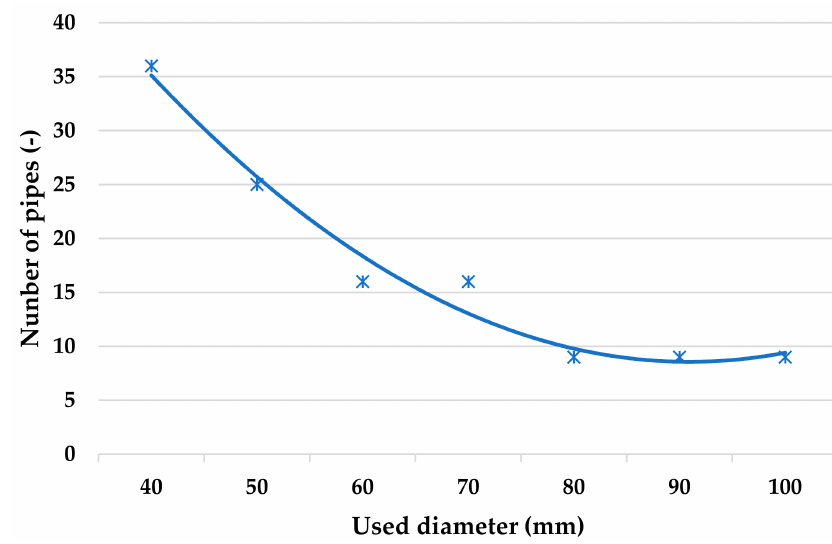
Figure 6. Maximal number of pipes by used outer